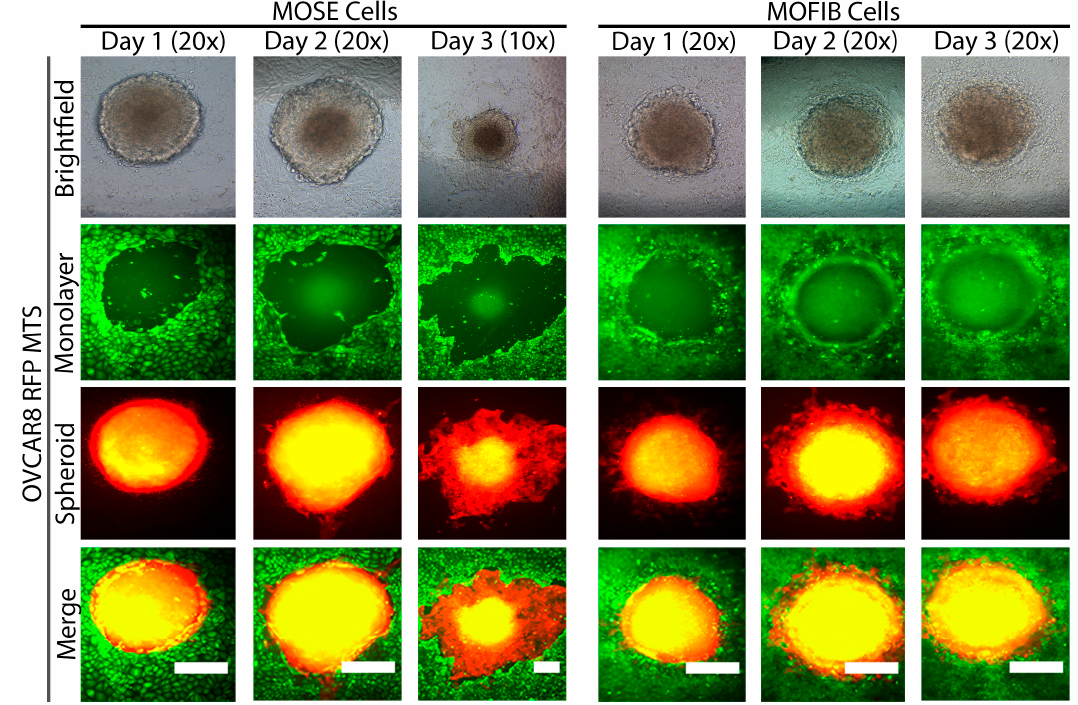
Figure 6. Representative images of the area cleared by OVCAR8 RFP MTS when plated on MOSE (left) or MOFIB (right) cells over three days. The area of MOSE cells cleared by OVAR8 RFP MTS was enlarged on Day 3, but the area of MOFIB cells cleared over three days remained constant. n = 4. Scale bar = 25 μ m.